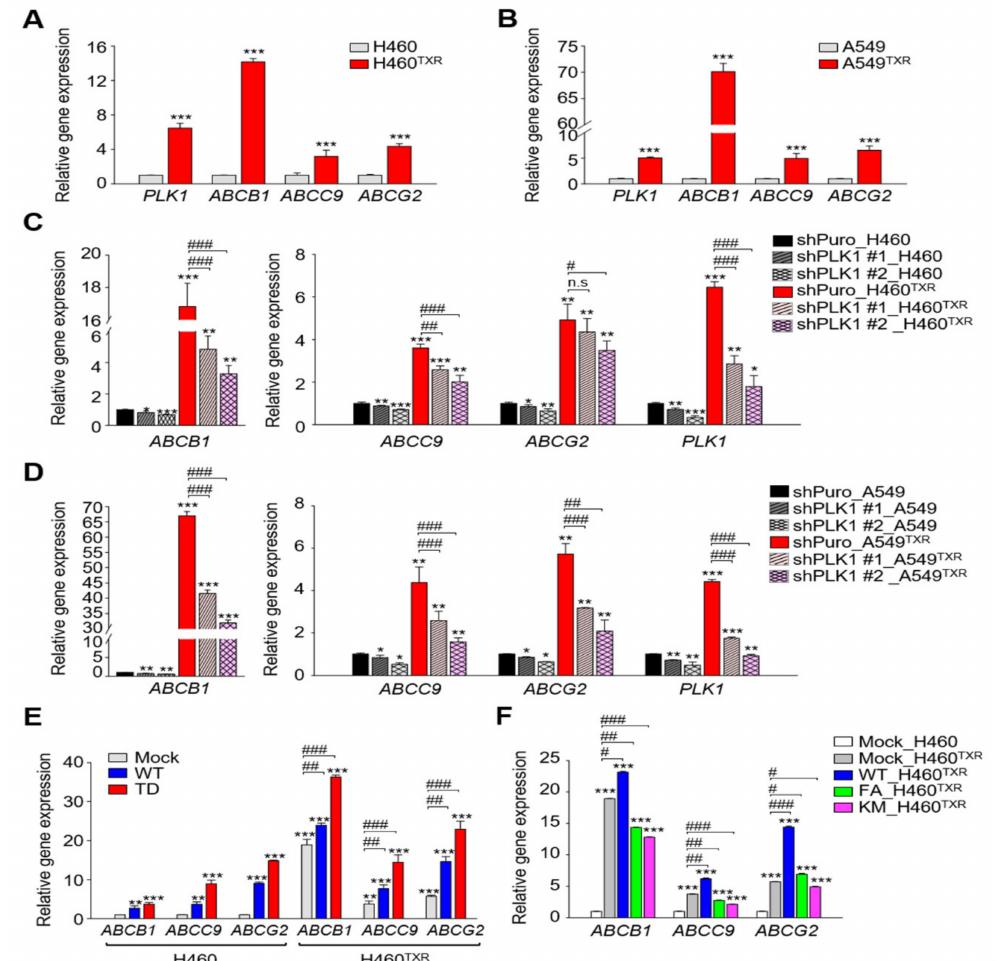
Figure 1. Expression levels of ABC transporters were regulated by PLK1 activity in paclitaxel- resistant lung cancer cells. ( A , B ) Quantitative RT-PCR was performed to evaluate the mRNA levels of PLK1 , ABCB1 , ABCC9 , or ABCG2 in parental and paclitaxel-resistant NCI-H460 (H460 TXR ) or A549 (A549 TXR ) cells. Three independent experiments were performed. The relative expression levels of mRNA were plotted. ***, p < 0.001. ( C , D ) Paclitaxel-resistant H460 TXR or A549 TXR cells were infected by lentiviral shRNA targeting PLK1 and then selected with puromycin for 48 h. Quantitative RT-PCR was performed to evaluate the mRNA levels of PLK1, ABCB1, ABCC9 , or ABCG2, and the relative expression levels were plotted. Three independent experiments were performed. *, p < 0.05; **, p < 0.01, ***, p < 0.001 compared with shPuro of parental cells. #, p < 0.05; ##, p < 0.01; ###, p < 0.001 compared with shPuro of TXR cells. ( E , F ) ERFP-tagged vector (Mock), wild-type (WT), or catalytically active T210D (TD) of PLK1 were expressed in parental and paclitaxel-resistant NCI-H460 cells ( F ) ERFP-tagged vector (Mock), wild-type (WT) variants of PLK1 were expressed in H460 TXR cells. Quantitative RT-PCR was performed to evaluate the mRNA level of ABCB1, ABCC9, or ABCG2 , and the relative expression of mRNA was plotted. Three independent experiments were performed. **, p < 0.01; ***, p < 0.001 compared with mock of parental H460 cells. #, p < 0.05; ##, p < 0.01; ###, p < 0.001 compared with compared with mock of H460 TXR